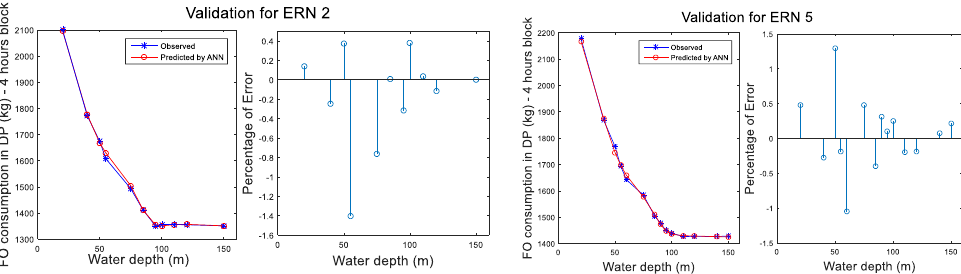
Figure 3. Comparison plot for observed and ANN predicted FO consumption values in DP-assisted station-keeping. The trained ANN is then further utilized to predict the fuel consumption values at various depths when there is no environmental force, which is ERN zero. Figure 4 shows a graphical plot for the ANN-predicted fuel consumption values for ERN 0 condition. The predicted values are for 4 h block, and as can be seen, the consumption is reduced with the increase in water depth and finally reaches a steady-state, as expected. Therefore, for daily consumption, the values are multiplied by six for cost calculation.